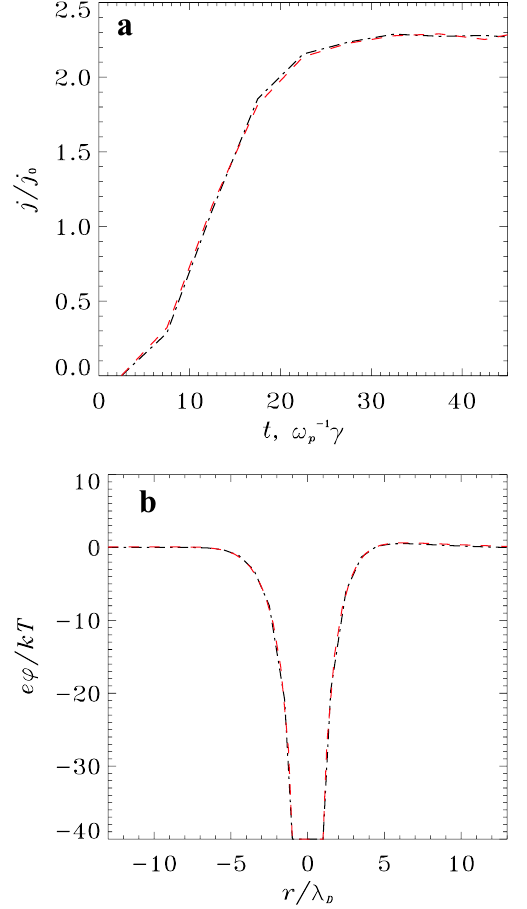
Fig. 4. (a) Ion current averaged over a period of 5 γω − 1 pe ; ( b) potential distribution along the x -axis parallel to the bulk ve- locity in the case of O + plasma with V 0 = 4 V Ti , λ D = r s = 2cm, T = 0 . 1 eV ,ϕ =− 40 kT/e . Red and black lines stand for the results of the model with the cell size of λ D / 2 and λ D , respectively.